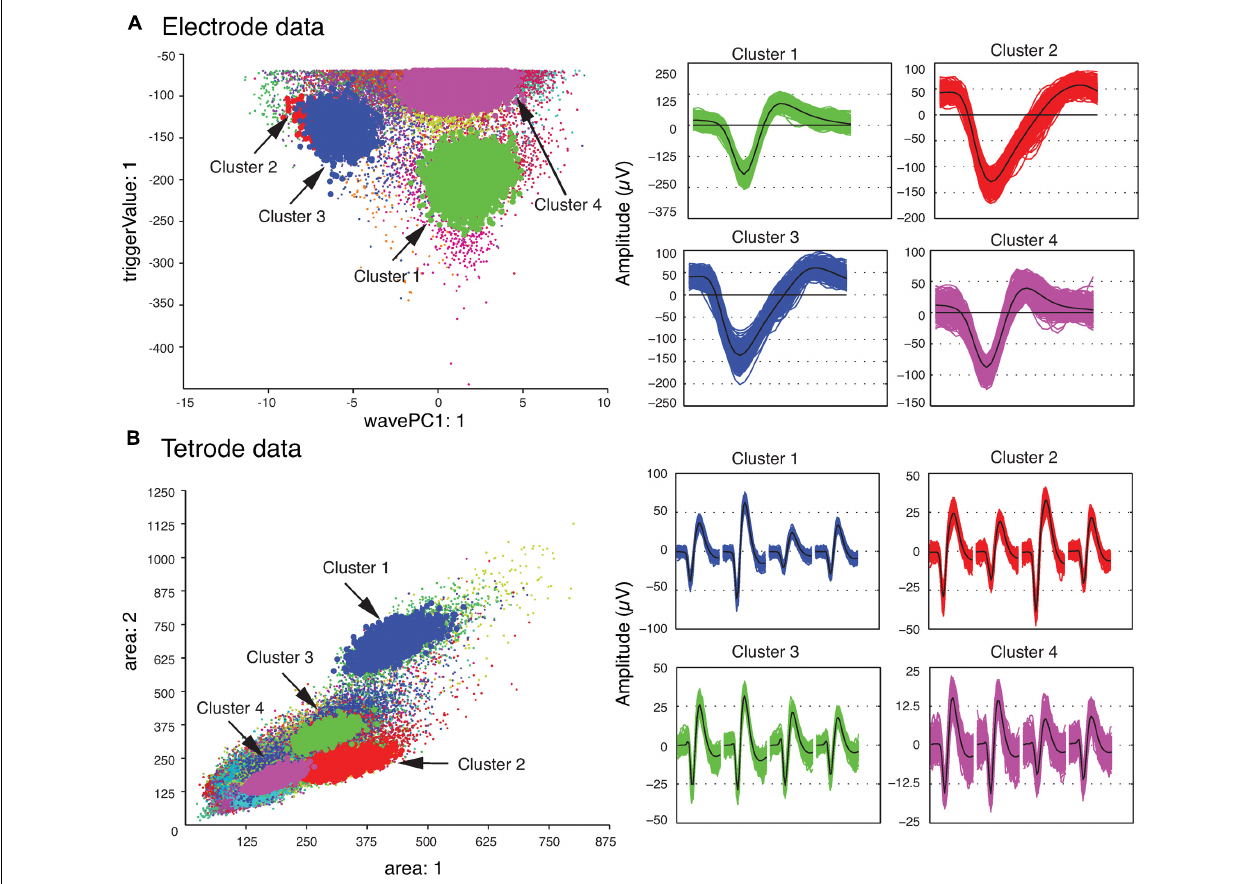
FIGURE 2 | Clustered waveforms and candidate template clusters. (A) Electrode data. The features shown are the first principle component on the horizontal axis, and the voltage at the trigger point on the vertical axis. (B) Tetrode data. The features shown are the waveform area for the first channel on the horizontal axis, and waveform area for the second channel on the vertical axis. (Left) Initial clusters. Clusters with large isolation distances are highlighted in red, green, blue, and magenta. Isolation distances for the electrode data computed using the features shown were: Cluster 1 – 33.0; Cluster 2 – 0.85; Cluster 3 – 4.79; Cluster 4 – 7.23. For tetrode data, they were: Cluster 1 – 2.75; Cluster 2 – 0.84; Cluster 3 – 0.85; Cluster 4 – 1.13. (Right) Waveforms corresponding to highlighted clusters. For the tetrode data, the 32 data points from each of the four channels are plotted next to each other. The average waveform for each cluster is plotted in